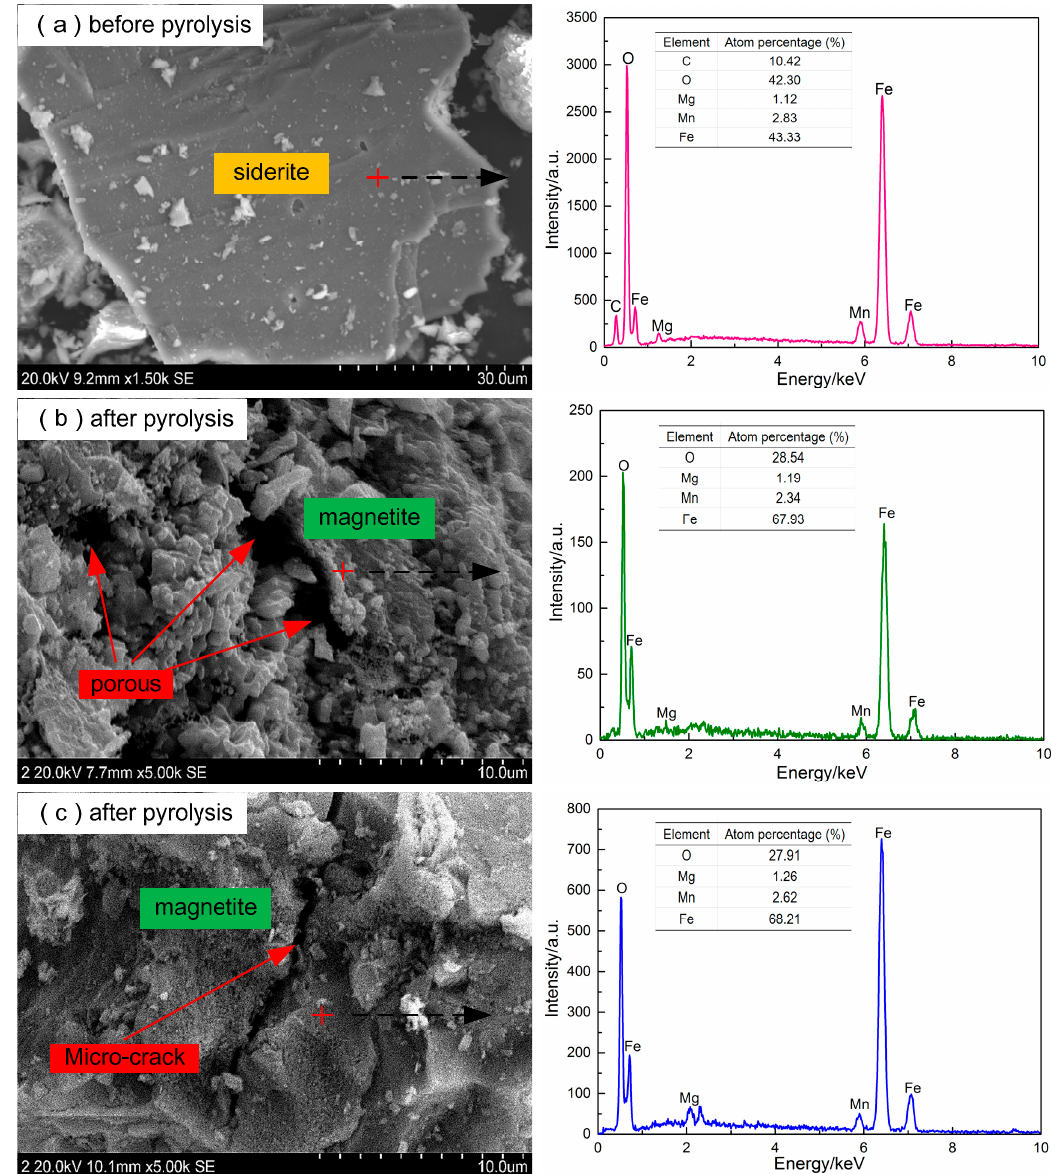
Figure 7. SEM and EDS analysis results of siderite before ( a ) and after ( b,c ) pyrolysis.